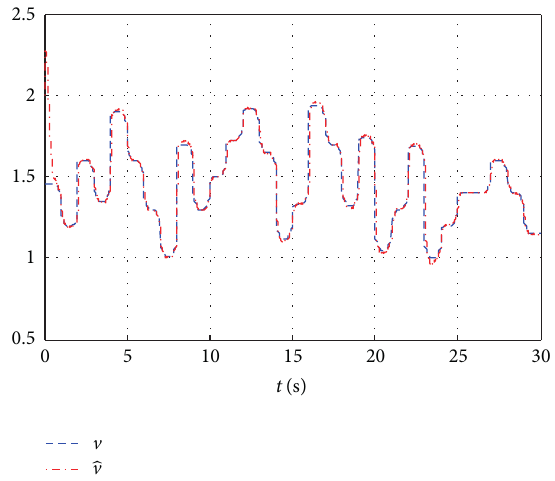
Figure 2: The unknown input and its